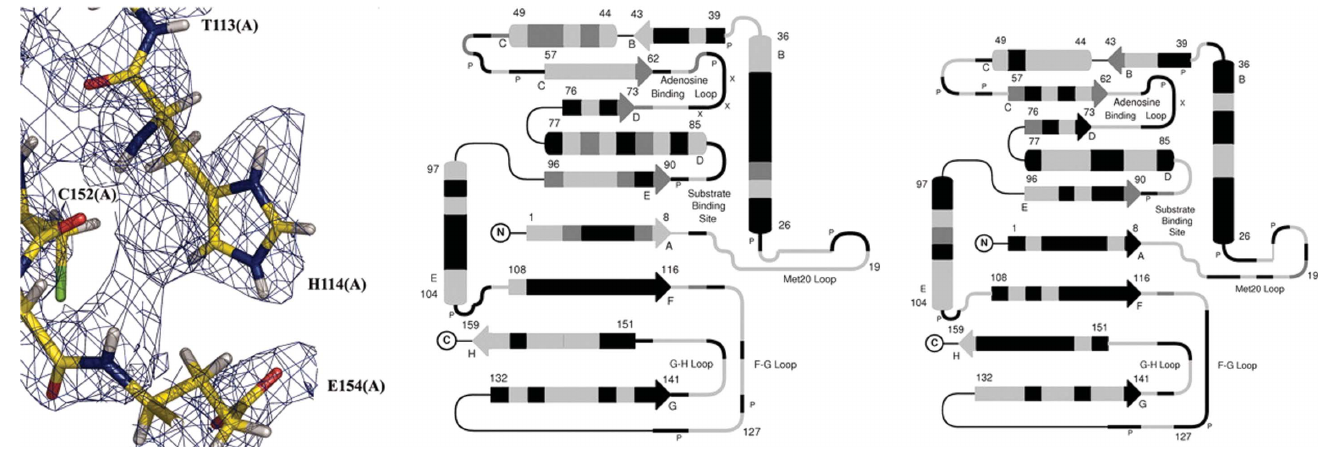
Figure 14 Left, nuclear 2 F o (cid:2) F c density for active-site residues, showing double protonation of His114. Middle and right, amide backbone H/D-exchange pattern for the two monomers of DHFR, ranging from gray (exchanged) to black (not exchanged). Reprinted with permission from Bennett et al. (2006), Proc. Natl Acad. Sci. USA , 103 , 18493–18498. Copyright (2006) National Academy of